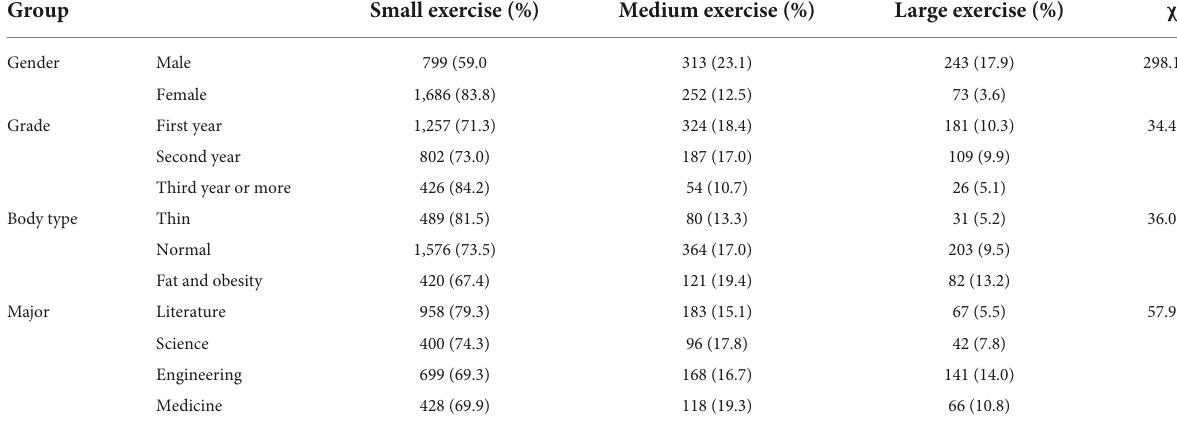
TABLE 2 Physical activity of college